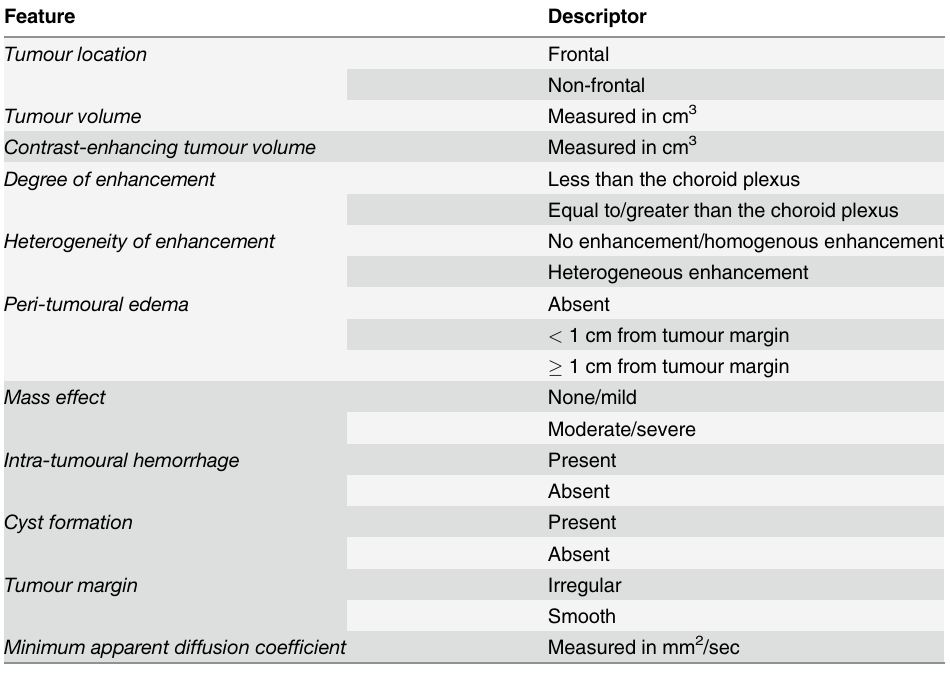
Table 1. Features and associated descriptors assessed on the pre-operative MR